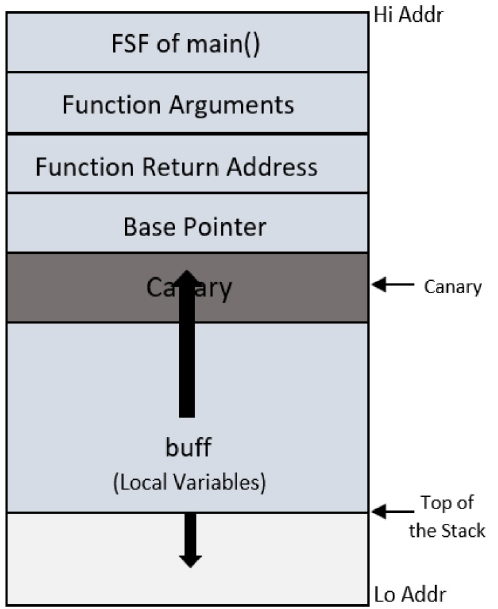
Figure 28. Stack with Canary word.